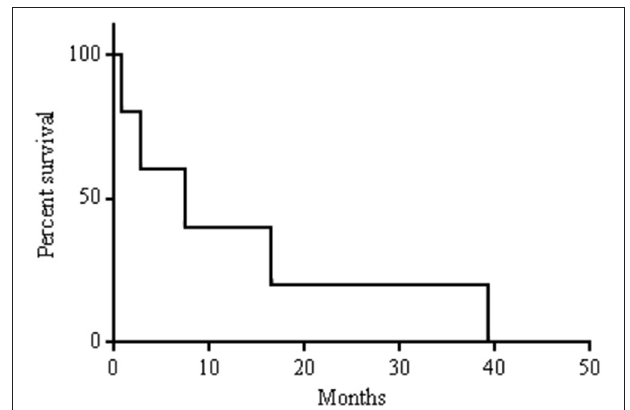
FIGURE 1 | Kaplan-Meier survival